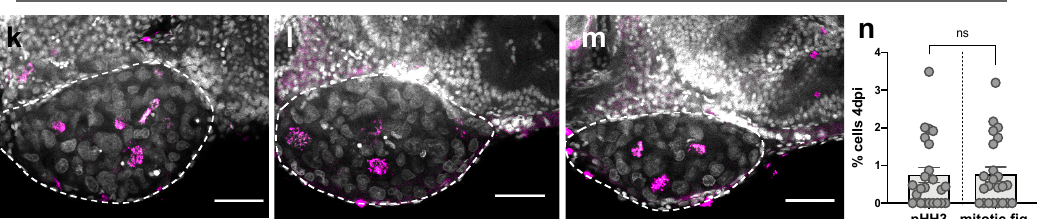
Figure 1. Characterization and histological analysis of human pancreatic cancer zebrafish xenografts. Human Panc-1 cells were fluorescently labeled with DiI (magenta) and injected into the perivitelline space (PVS) of 2 days postfertilization (dpf) Tg ( fli1:eGFP ) zebrafish embryos ( a – d ). At 1 day post-injection (dpi), zebrafish xenografts with severe cardiac edema were discarded ( a ), and successfully injected xenografts ( b ) were divided according to their tumor size (+, ++, +++) and were kept at 34 °C until the end of the experiment. At 4 dpi, zebrafish xenografts were evaluated regarding the presence of tumor (% engraftment) ( c,e ), tumor size ( f ), and angiogenic capacity ( d ). Representative H&E-stained microphotographs of paraffin-embedded Panc-1 zebrafish xenografts at 4 dpi showing how Panc-1 cells implant in close proximity to the zebrafish pancreas, liver, and gut ( g – j’ ). Scale bars represent 100 µm. ( k – m ) Representative confocal images of mitosis revealed by pHH3 staining (magenta) and DAPI (labeling condensed chromatin that enables detection of mitotic figures) and quantification of mitotic index—% mitotic figures and % pHH3 ( n ). All results are expressed as AVG ± SEM and correspond to at least 3 independent experiments. The number of zebrafish xenografts analyzed is indicated, and each dot represents one zebrafish xenograft. Scale bars represent 50 µm. All images are anterior to the left, posterior to right, dorsal up, and ventral down.